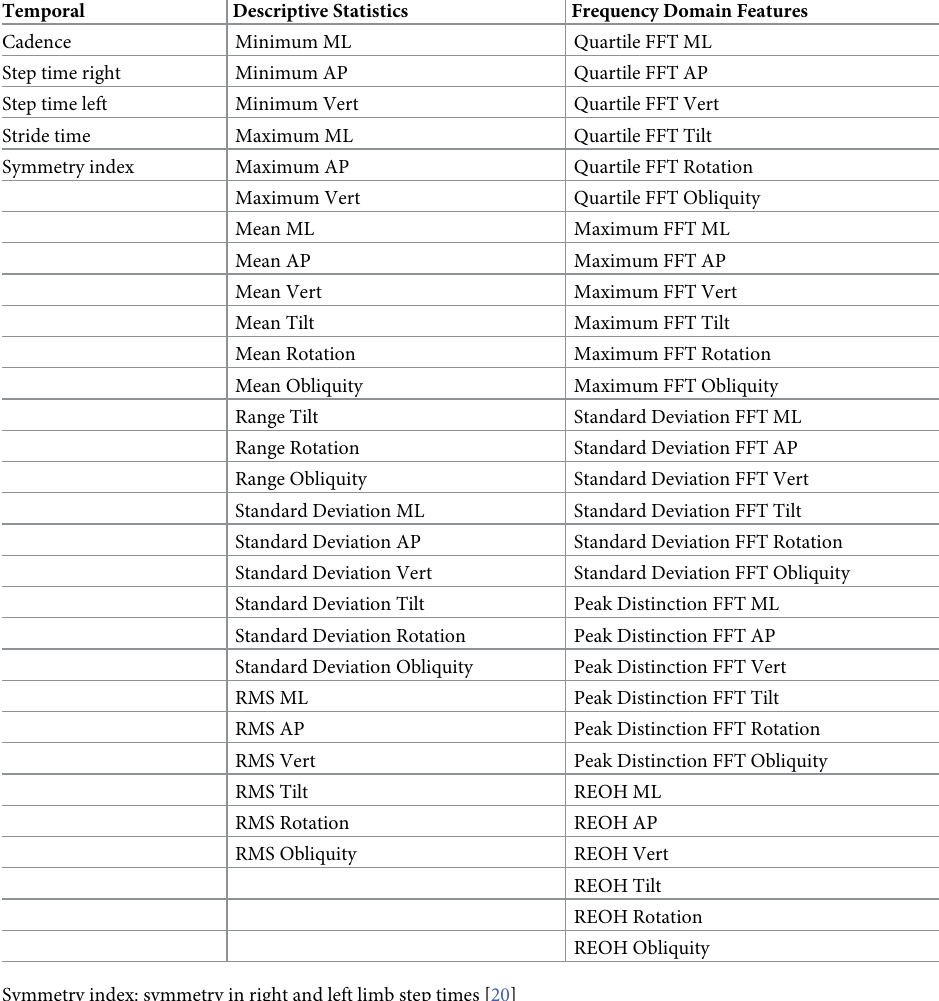
Table 2. Feature list for fall risk classification. AP = anterior-posterior; ML = medio-lateral; RMS = root-mean square; FFT = fast Fourier transform; REOH = ratio of even/odd harmonic frequencies.